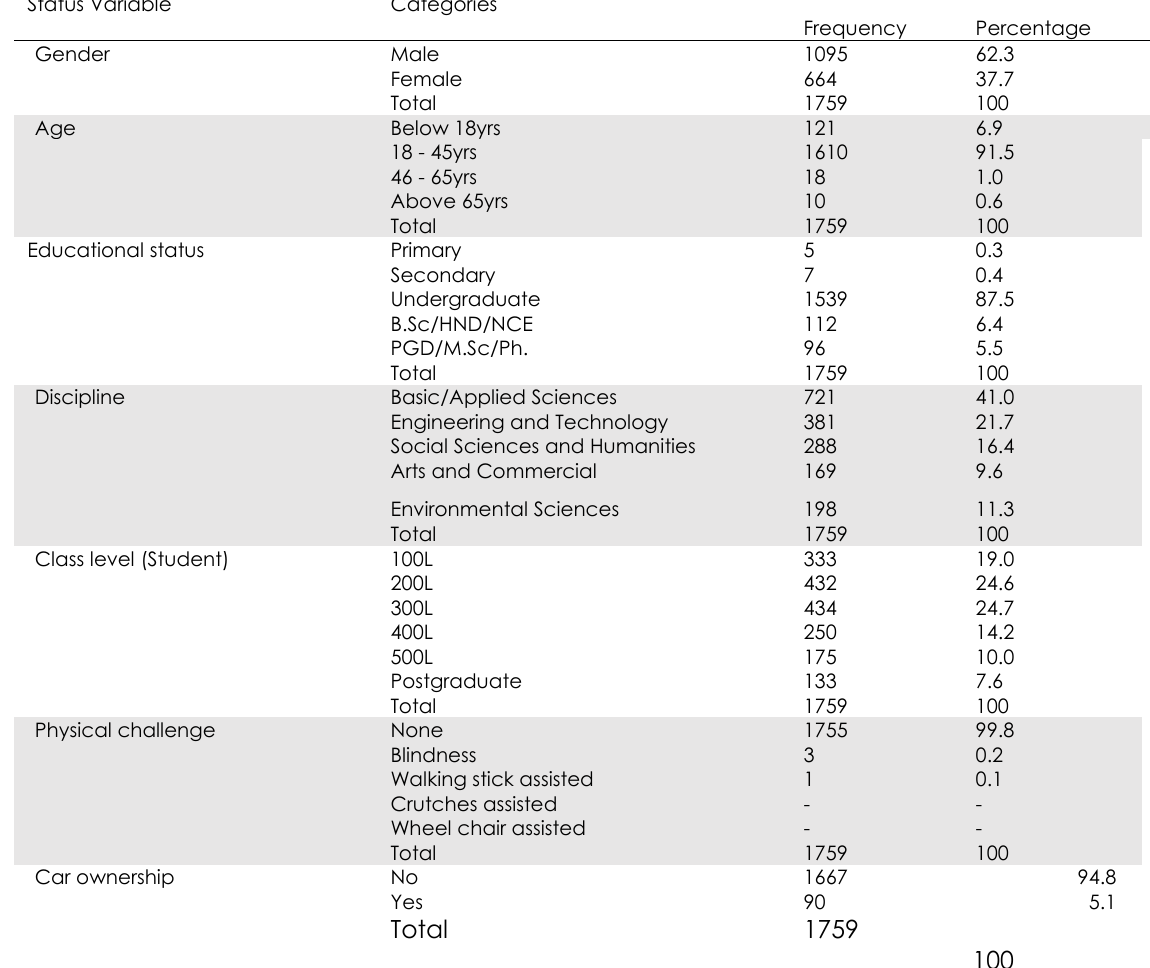
Table 1. Status of users of the UZGs in South-west Nigeria.